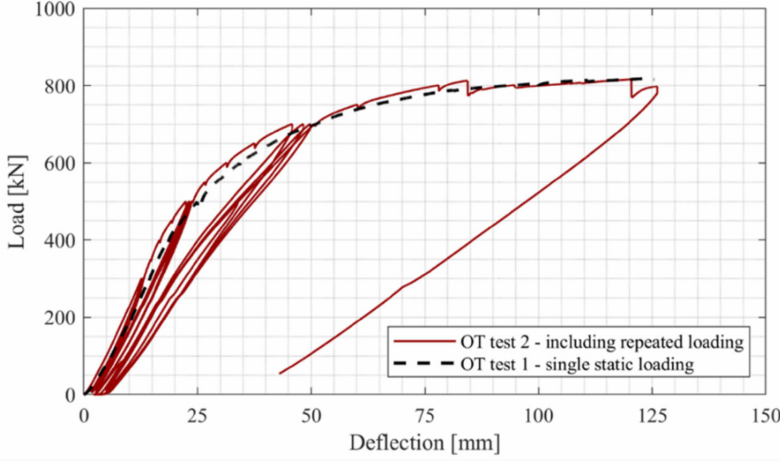
Figure 11. Test response